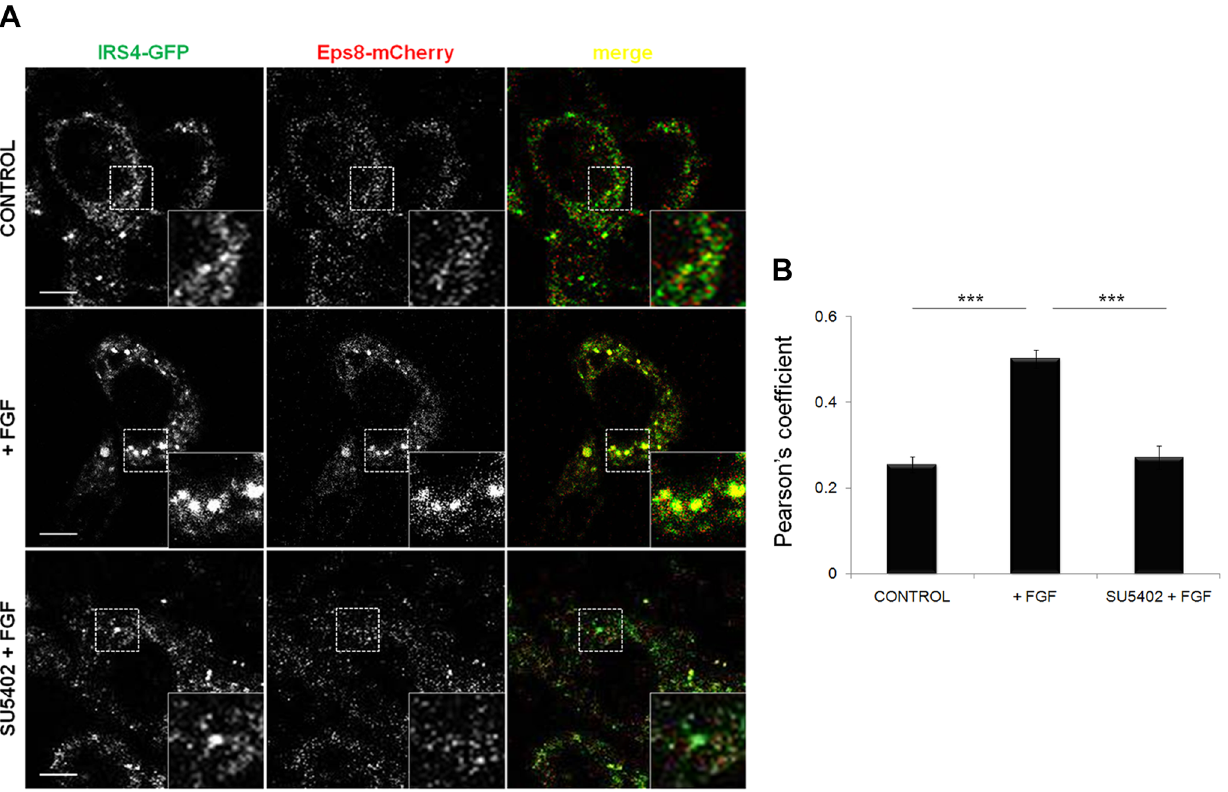
Figure 7. Eps8 and IRS4 colocalise within cells in an FGF2 dependent manner. NIH 3T3 cells were co-transfected with IRS4-GFP and Eps8- mCherry. Cells stimulated with FGF2 (20 ng/ml) in the presence and absence of SU5402 (25 m M) were compared to unstimulated cells (control). A) Confocal microscopy was used to visualise the localisation of IRS4 and Eps8. B) The colocalisation (Pearson’s coefficient) between IRS4 and Eps8 is significantly increased in the presence of FGF2 and absence of SU5402 (Pearson’s coefficient, mean 6 SEM, n=42 cells. Scale bars=5 m m. ***, P , 0.001).